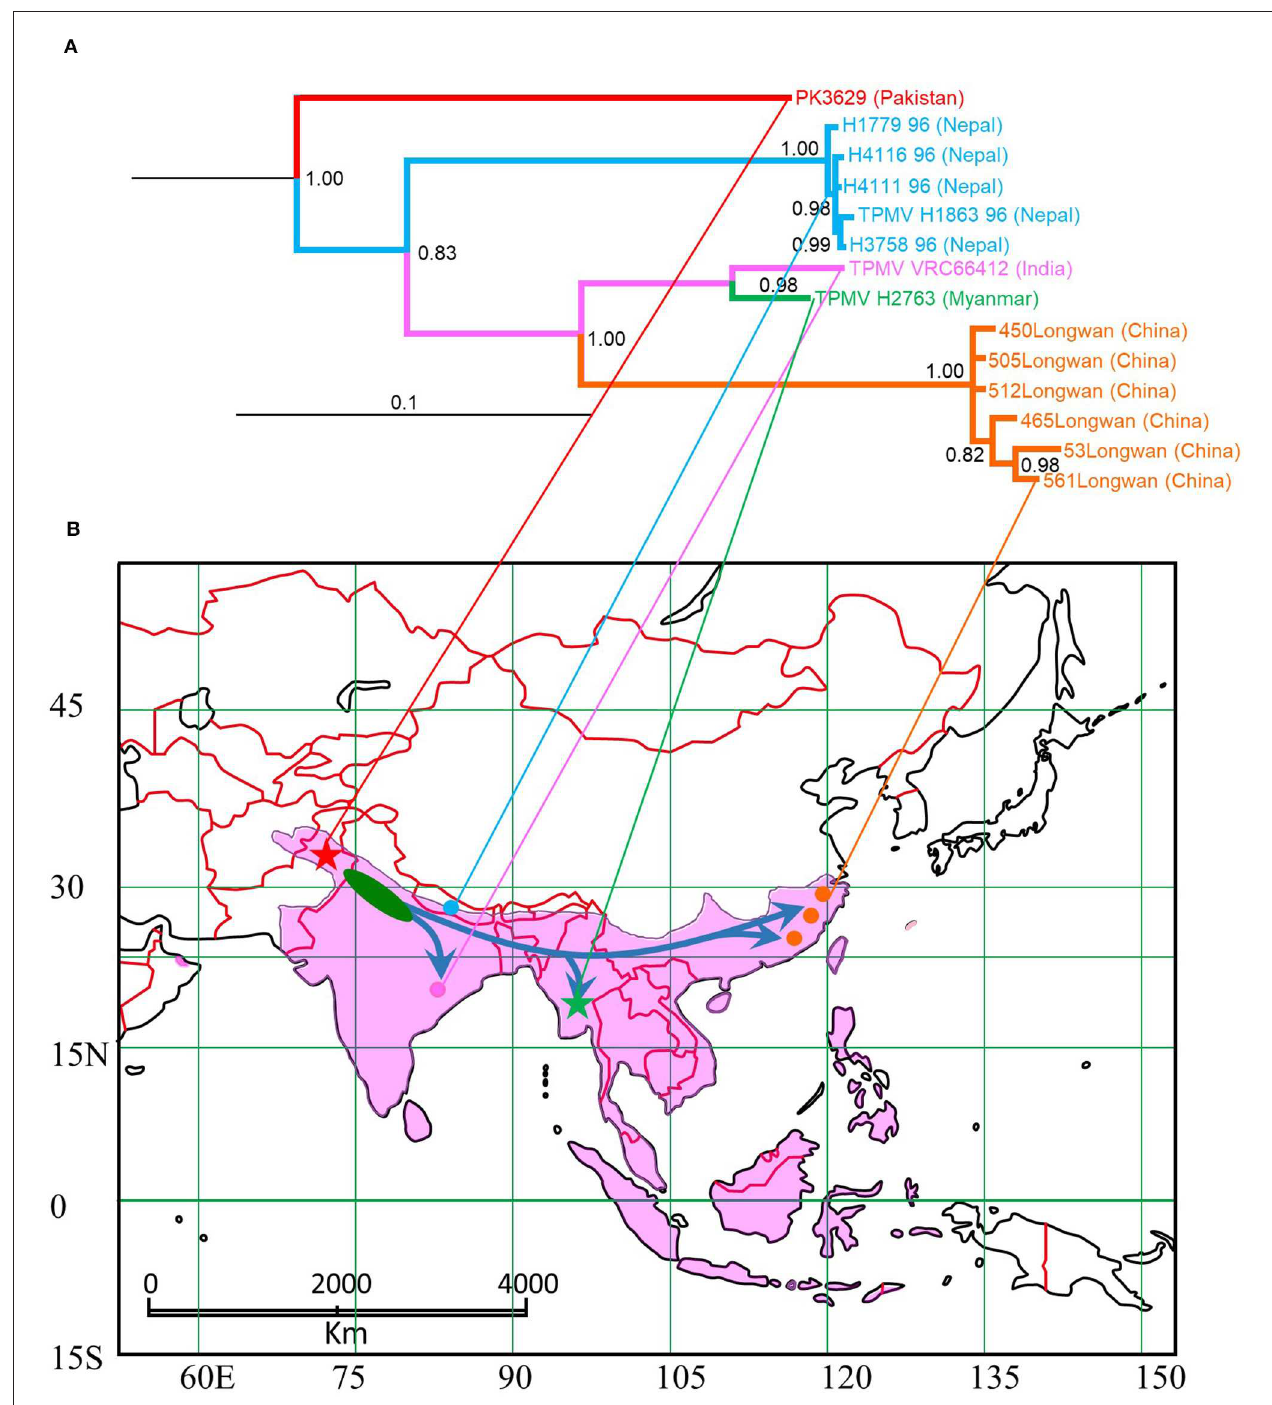
FIGURE 6 | Map of distribution of Asian house shrew and phylogenetic tree based on L segment of TPMV. (A) TPMV cluster based on L-segment in phylogenetic analysis. (B) Blue arrows in map were estimated expansion root based on TPMV phylogeny. Pakistan strain was captured at red star, Nepal strains (Kang et al., 2011c) were captured at light blue circle, Indian strain (Carey et al., 1971) was captured at pink circle, Myanmar strain was captured at green star and Chinese strains (Guo et al., 2011) were captured at red circles. Pakistan and Myanmar strains were collected in this study (star symbols). Pink area is shown Asian house shrew distribution (Ohdachi et al.,